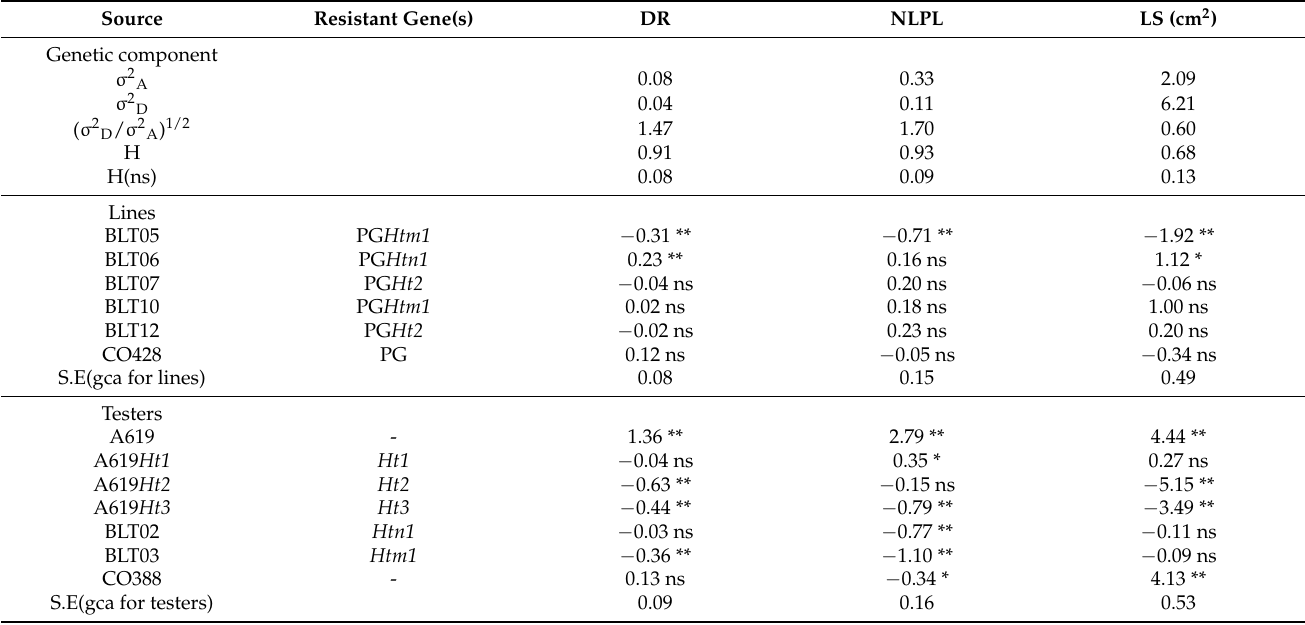
Table 4. Genetic component, heritability (H), and heritability in the narrow sense (H(ns)), and general combining abilities of CO428-related Line × Tester analysis for disease rating (DR), number of